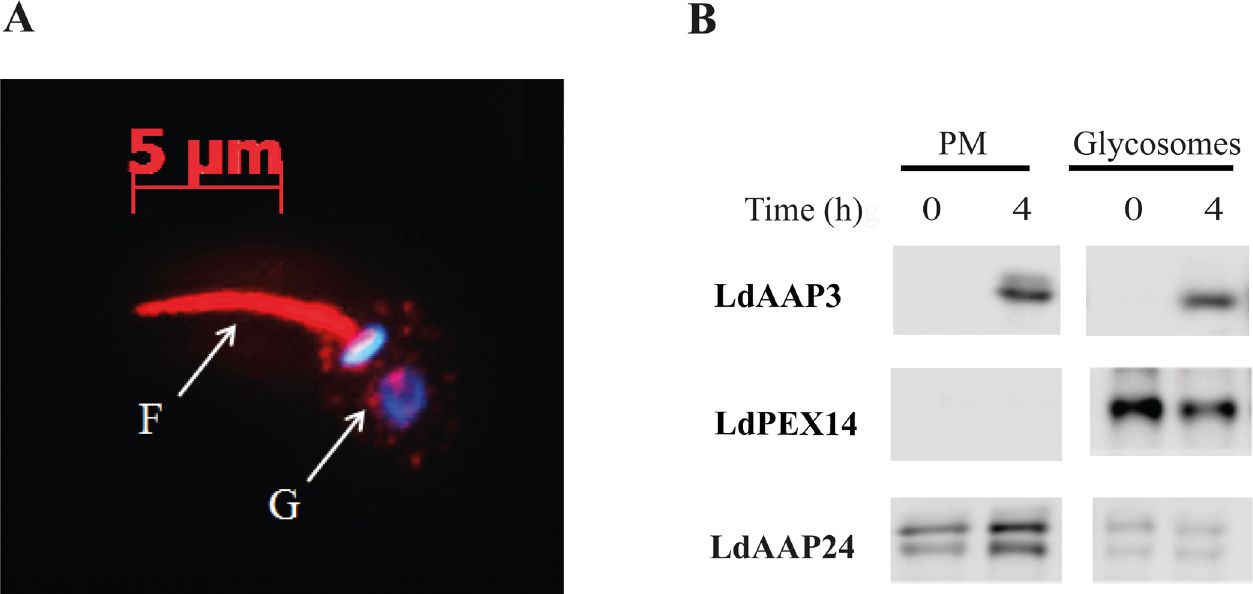
Fig 2. LdAAP3 localizes to both flagella surface and glycosome membranes. A) Indirect immunofluorescence of LdAAP3. Axenic L . donovani promastigotes were stained using anti LdAAP3 IgG (red) and the DNA stain DAPI (blue). The latter stained the nucleus and kinetoplast. The two immunofluorescence images were merged. Immunofluorescence analysis was performed using the inverted cell observer Zeiss Axiovert 2. B) Subcellular distribution of LdAAP3. Axenic L . donovani promastigotes before and after 4 hours of arginine deprivation were extracted, non-soluble membranes were separated and subsequently subjected to sucrose gradient (20 – 60%) as described in Materials and Methods. Aliquots of plasma and glycosome membrane fractions before and after arginine deprivation were subjected to western blot analysis. Anti proline/alanine transporter (LdAAP24) and PEX14 were used as plasma and glycosome membrane markers, respectively. LdAAP3 molecular mass is 46 kDa. Note that length of exposure to peroxidase chemiluminescense was calibrated to starved cells. Bands in non-starved cells were visible after longer exposure (not shown).